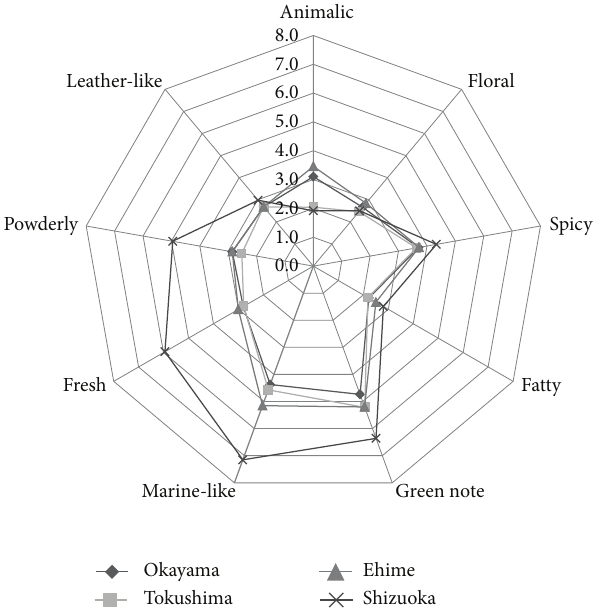
Figure 2: Sensory characterisation of green algae samples. The following aroma attributes were determined based on panelist’s evaluation: animalic, floral, spicy, fatty, green note, marine-like, fresh (waterly), powdery, and leather-like.